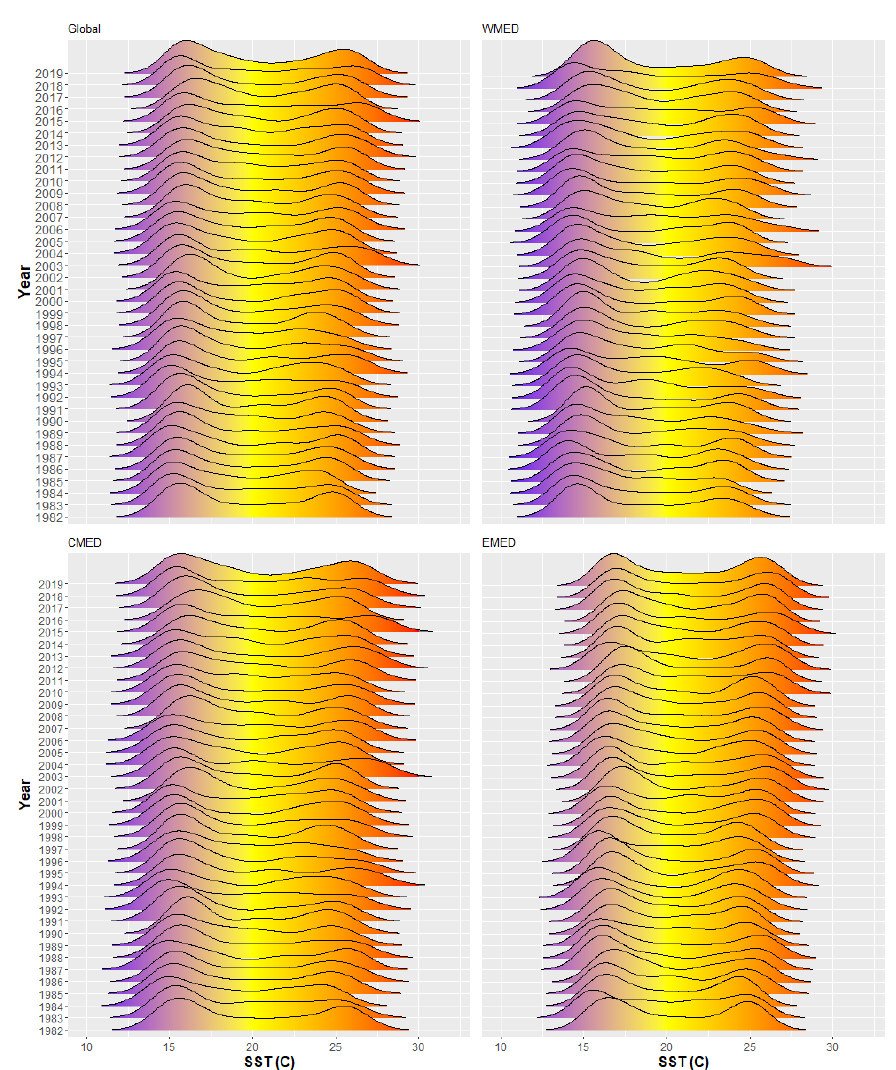
Figure 7. Yearly density plot for Mediterranean SST in the whole basin and WMED, CMED and EMED sub-basins.